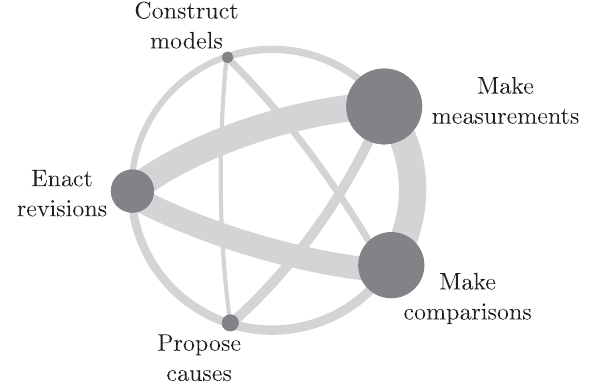
FIG. 4. Aggregated data from participants on duration and sequence of modeling subtasks. This schematic shows the commonality of the five modeling subtasks: construct models, make measurements, make comparisons, propose causes, and enact revisions. The area of the circles represents the number of 30-sec intervals coded with that particular subtask; the thickness of the gray connectors between all five subtasks represents the number of times a subtask was coded directly after the other, or within the same 30-sec interval. This representation is similar to the transition graphs presented in Ref.